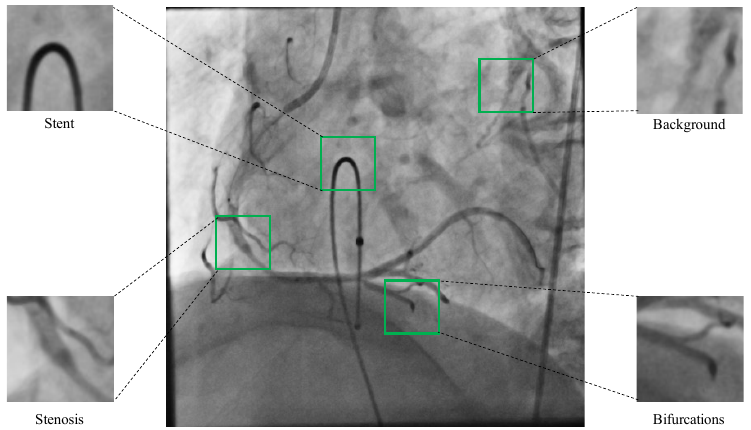
Figure 1. XCA image with specific characteristics regions highlighted, such as a stent, background artifacts, coronary blood vessels with bifurcations, and stenosis